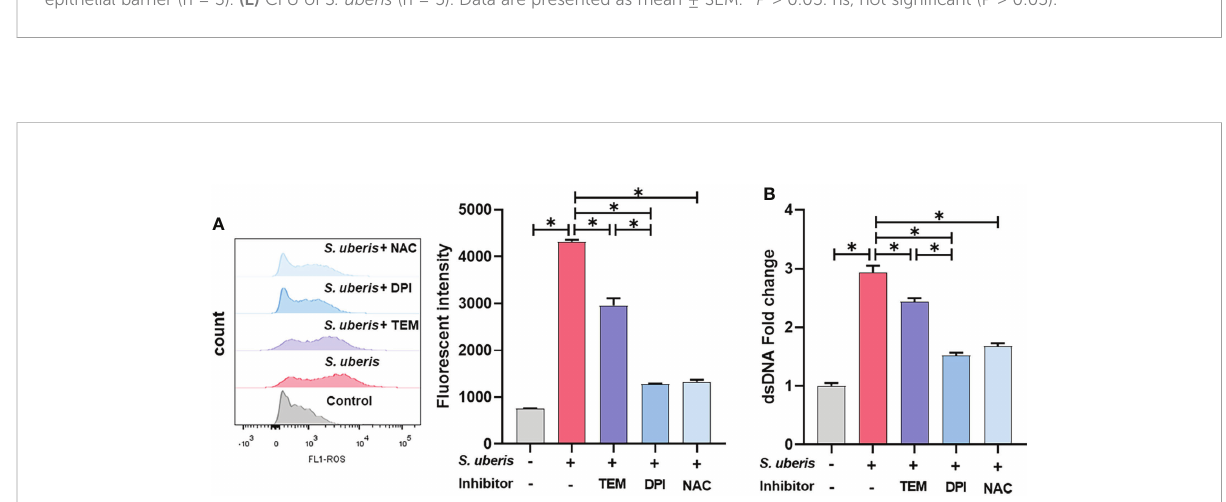
FIGURE 2 NADPH oxidase-mediated ROS dominate the production of NETs in S. uberis infection. The neutrophils were pretreated with NAC (5 mM), DPI (2 m M) and mitoTEMPO (TEM, 10 m M) for 1 h before infected with S. uberis at MOI of 10 for 2 h at 37°C. (A) The intracellular ROS level evaluated by Flow Cytometry. (B) The dsDNA content in supernatant. Data are presented as mean ± SEM (n = 3). * P < 0.05.